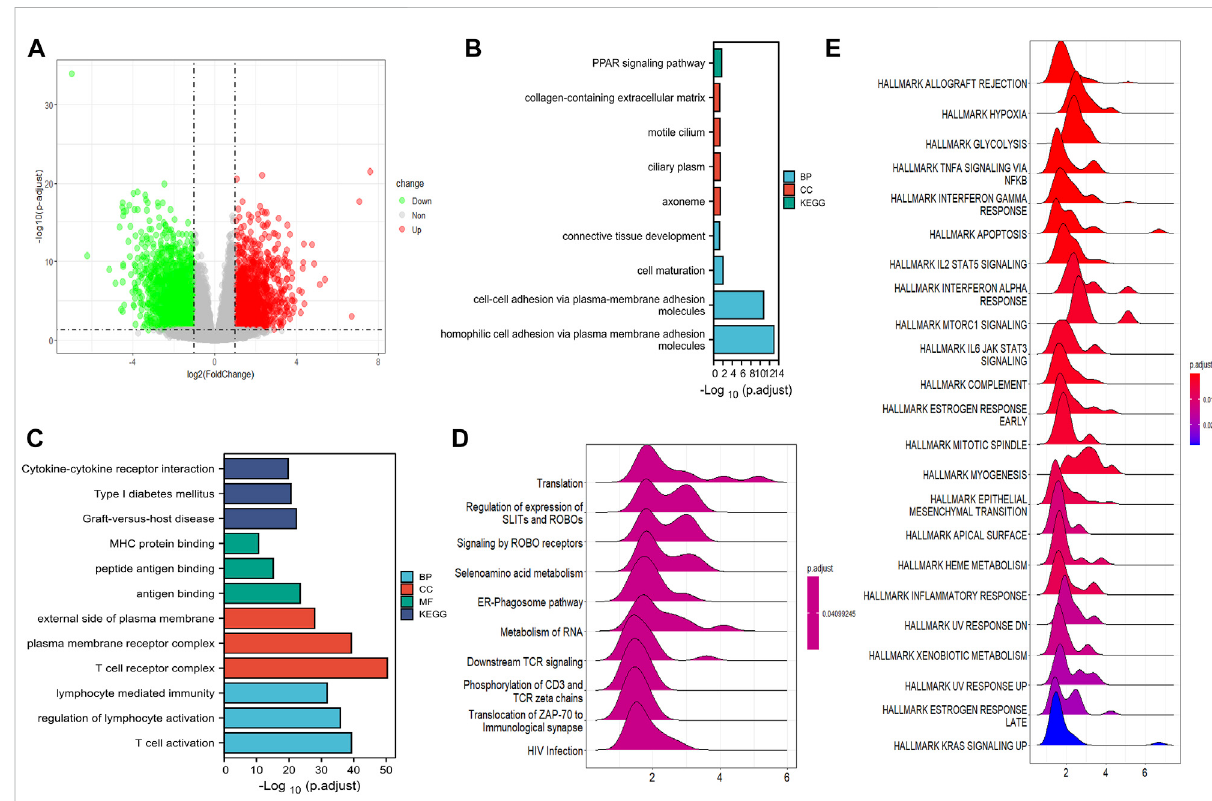
FIGURE 6 Function analysis of DEGs. (A) The volcano plot depicts the genes with differential expression between the high- and low-risk groups in TCGA cohort. (B) GO and KEGG analysis of the downregulated CRGs. (C) GO and KEGG analyses of the upregulated DEGs. (D) GSEA results of DEGs in GO datasets. (E) The DEG enrichment in the hallmark gene set by GSEA